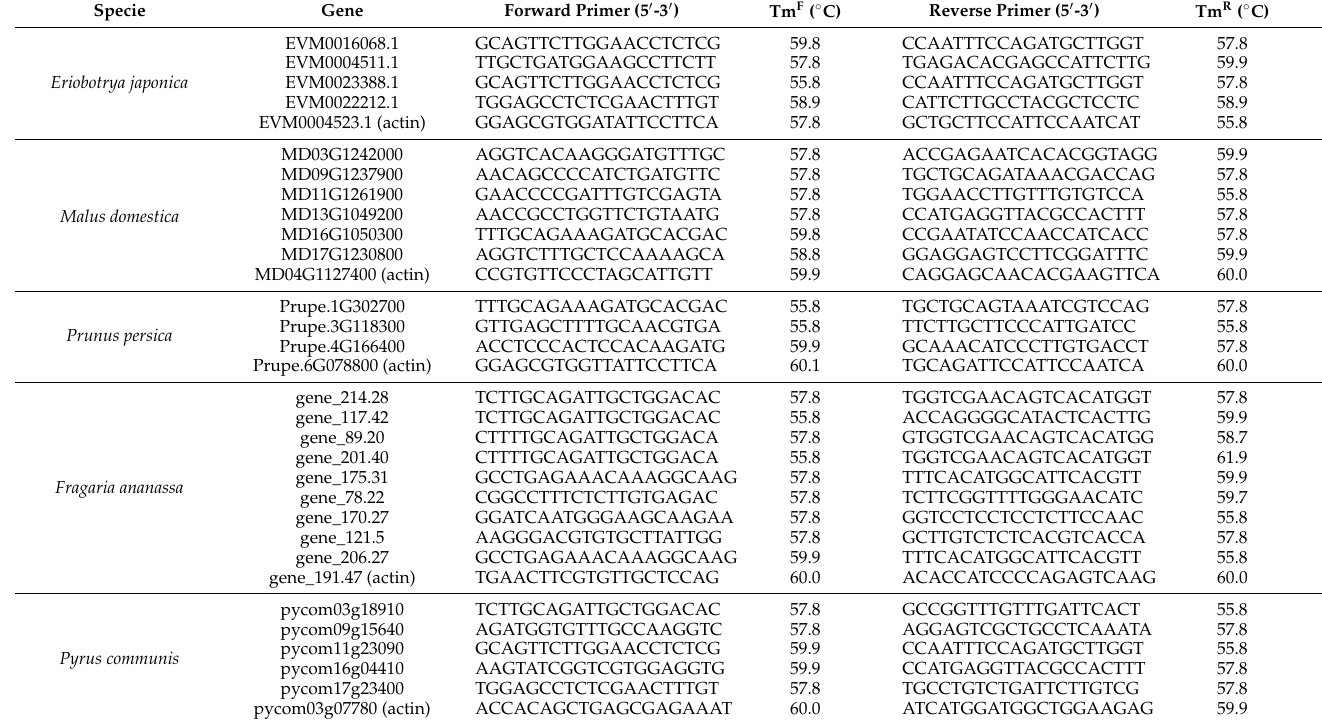
Table 1. Details about primer sequences of PEPC genes of five Rosaceae